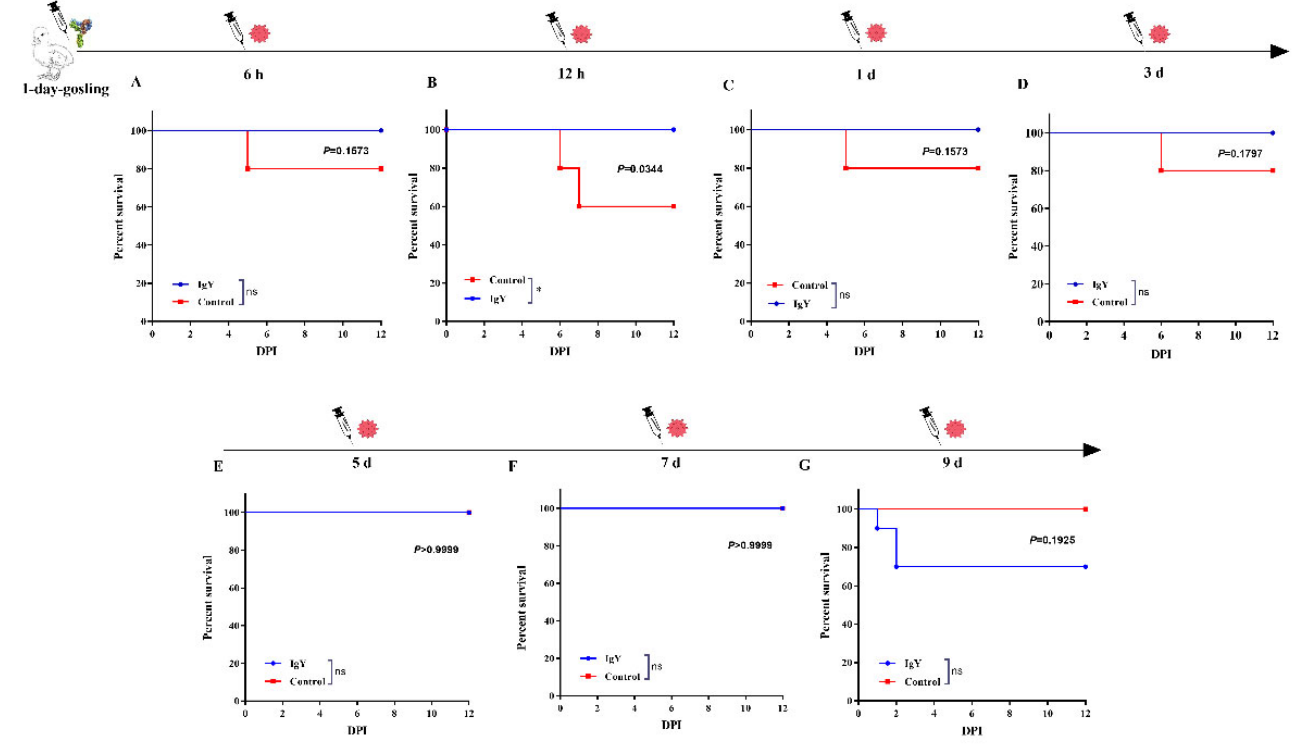
Figure 4. The survival rates of the G6–G19 ( A – G ). G6–G12 were subcutaneously inoculated with 0.9 mL IgY on day 1, while G13–G19 were corresponding control groups administrated with an equal volume of PBS, and subsequently, each group was challenged with 10 5.84 TCID 50 of the live GAstV at 6 h, 12 h, 1 d, 3 d, 5 d, 7 d, and 9 d post inoculation subcutaneously. The survival rates of G6–G19 were monitored daily. Survival data were analyzed by log-rank (Mantel–Cox) test. p values are expressed as mean ± SD, * p < 0.05; ns p > 0.05.